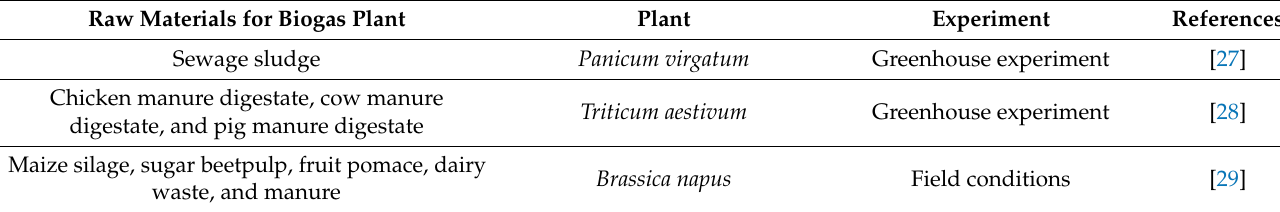
Table 2. Fertilizer use of